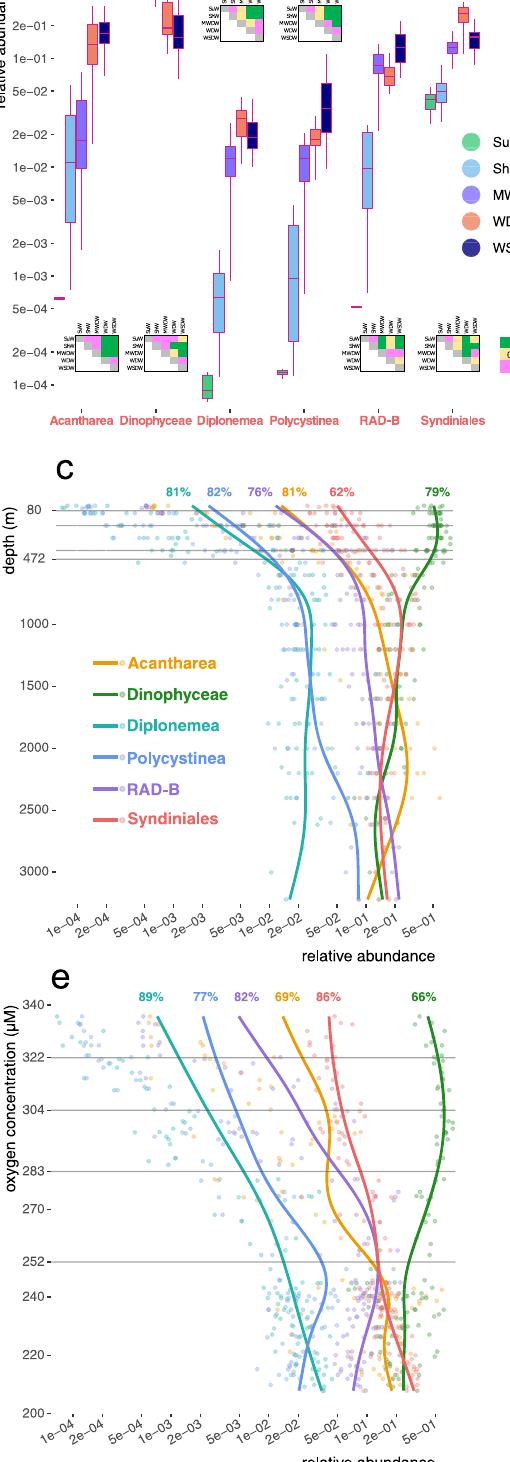
microorganisms, 9,14 . For example, Wilkins et al. 35 showed that advection (transport by water masses such as CDW, AABW, Antarctic Intermediate Water, and Subantarctic Mode Water) shapes prokaryotic communities in the Southern Ocean, con- trolling for effect of environmental variables and distance.